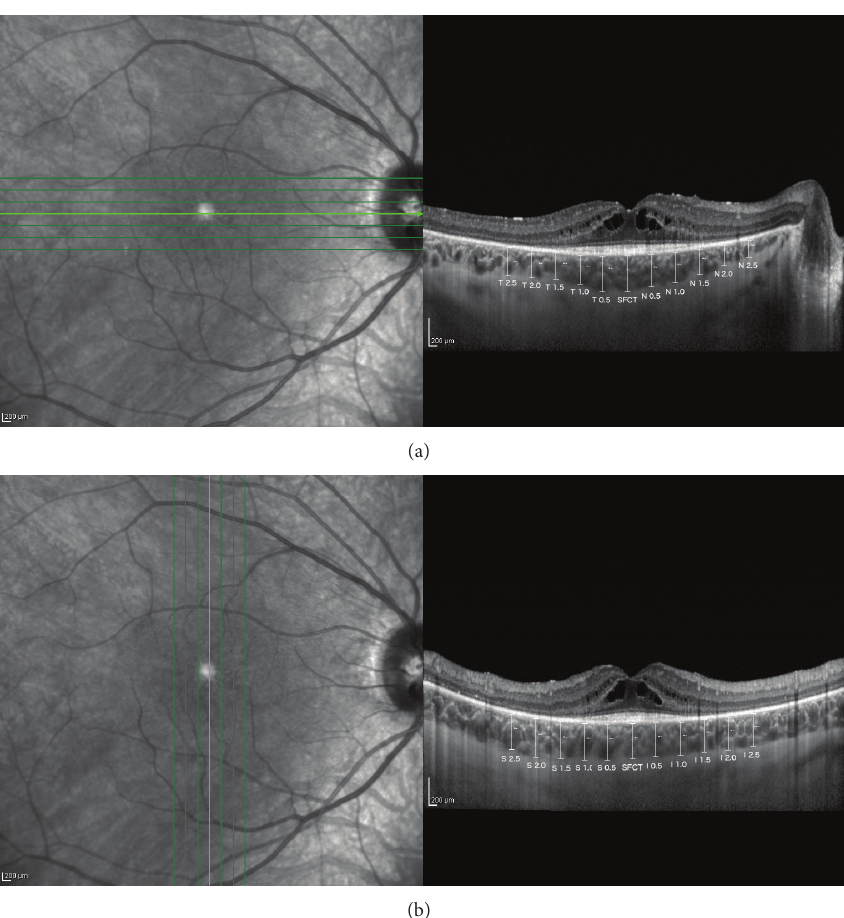
Figure 1: Horizontal (a) and vertical (b) choroidal and retinal measurements were taken manually in a masked fashion by two experienced OCT-readers. Values in the black boxes represent the topographic location of each measurement (T = temporal, N = nasal, S = superior, I = inferior, and SFCT = subfoveal choroidal thickness).